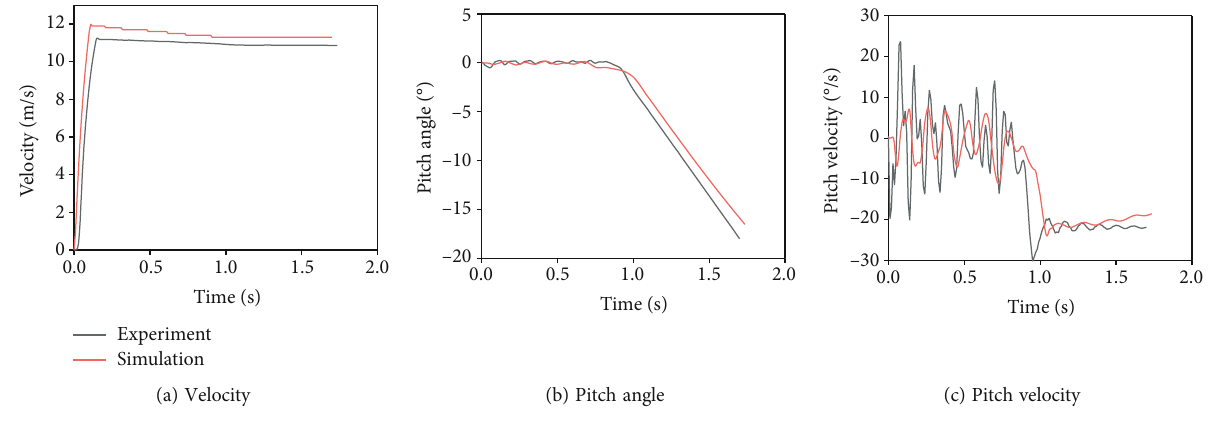
Figure 7: Comparison of FEM and experiment of missile movement. Table 2: The results from di ff erent simulate models.